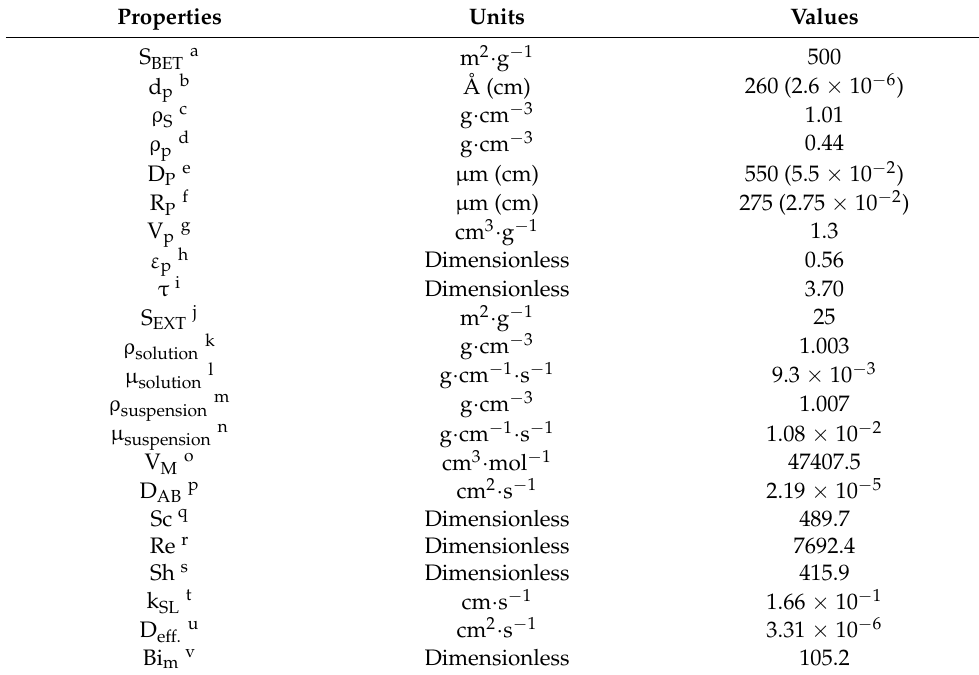
Table 2. Properties of the support, enzyme solution and suspension solid–liquid for the determination of fluid mechanics and mass transfer parameters of the adsorption process (preparation of the heterogeneous